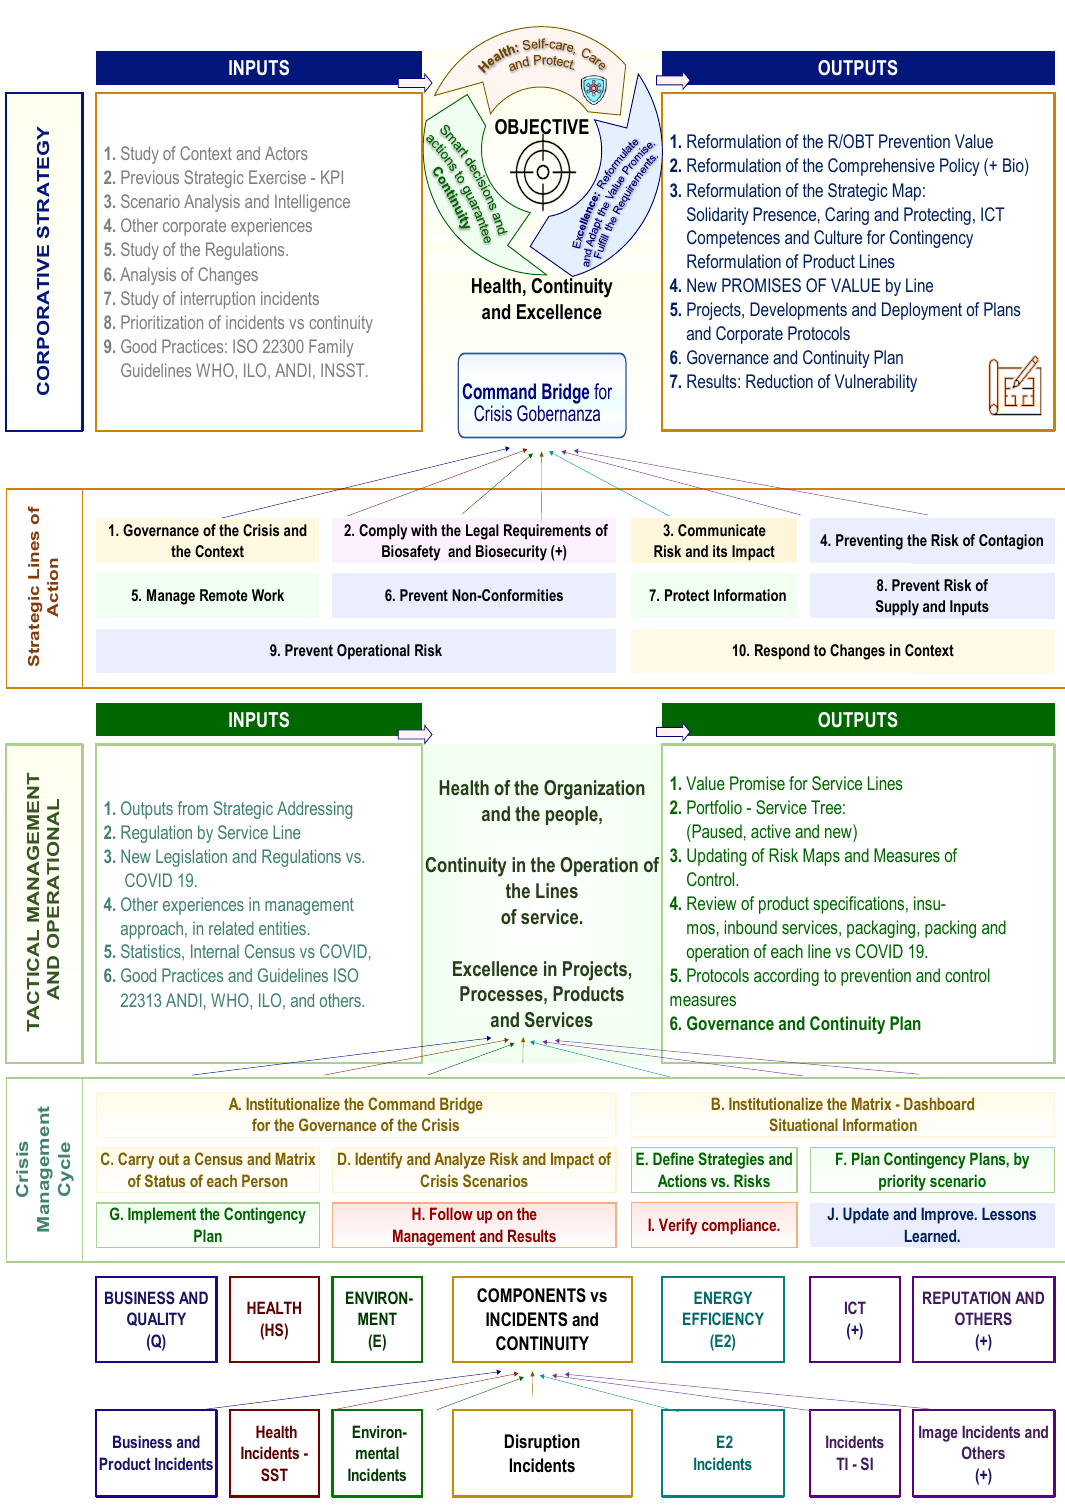
Figure A6. Strategic and Operational Approach to Biosafety and Biosecurity Continuity Plan. [50,51,65,66].